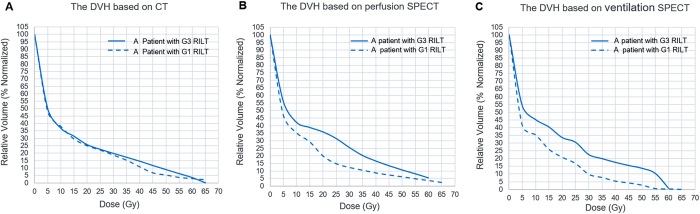
(A) The comparison of anatomical DVH based on CT in a patient with G3 (Grade 3) RILT and a patient with G1(Grade 1) RILT. (B) The comparison of functional DVH based on perfusion SPECT in a patient with G3 RILT and a patient with G1 RILT. (C) The comparison of functional DVH based on ventilation SPECT in a patient with G3 RILT and a patient with G1 RILT. DVH, dose volume histogram; CT, computerized tomography; RILT, radiation-induced lung toxicity; SPECT, single-photon emission computerized tomography.